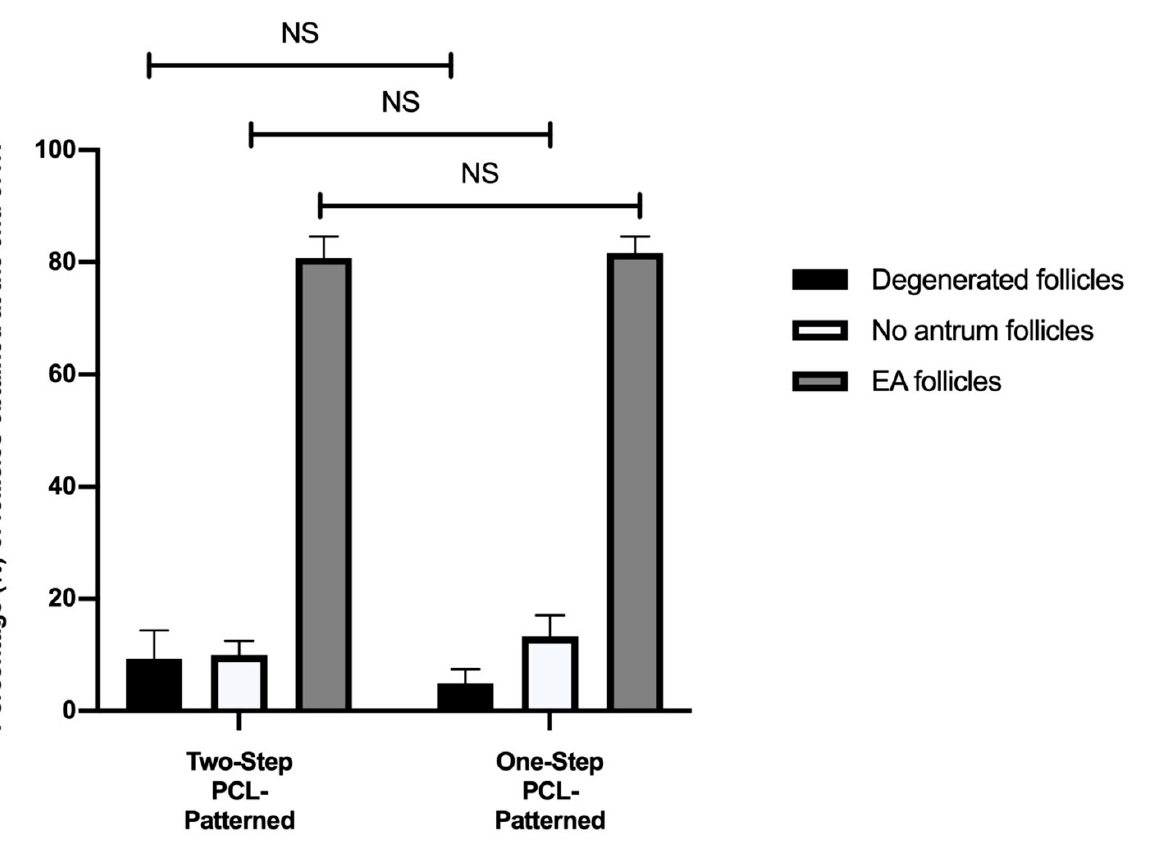
Figure 9. Percentage (%) of degenerated, no antrum and EA follicles per groups at the end of ivF culture. A total of 120 and 120 follicles were cultured in three independent experiments during which Two-Step PCL-Patterned and One-step PCL-Patterned electrospun scaffolds were simultaneal compared (Two-Step PCL-Patterned: 40, 40, and 40 PA follicles per experiment; One-Step PCL- Patterned: 40, 40, and 40 PA follicles per experiment). NS: not statistically